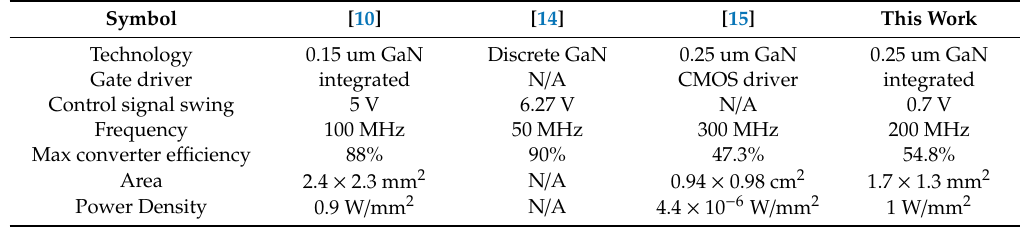
Table 1. Performance comparison with previous DC-DC